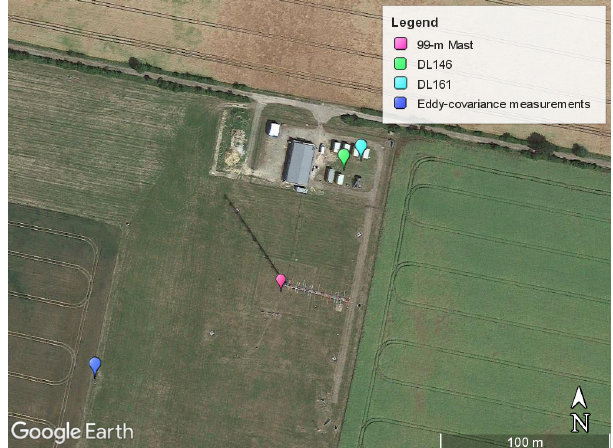
Figure 1. Measurement location in Falkenberg, MOL-RAO (source: © Google Earth).